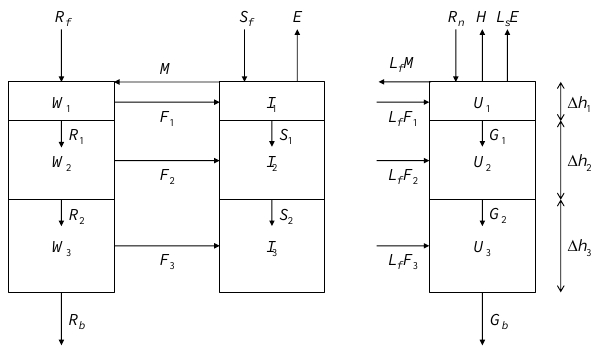
Figure 2. Subsystem diagram for a three-layer snowpack model with linked conservation equations for liquid water, ice and inter- nal energy. The F , G , M , R and S fluxes represent freezing, heat conduction, melt, drainage of liquid water and redistribution of ice between model layers,